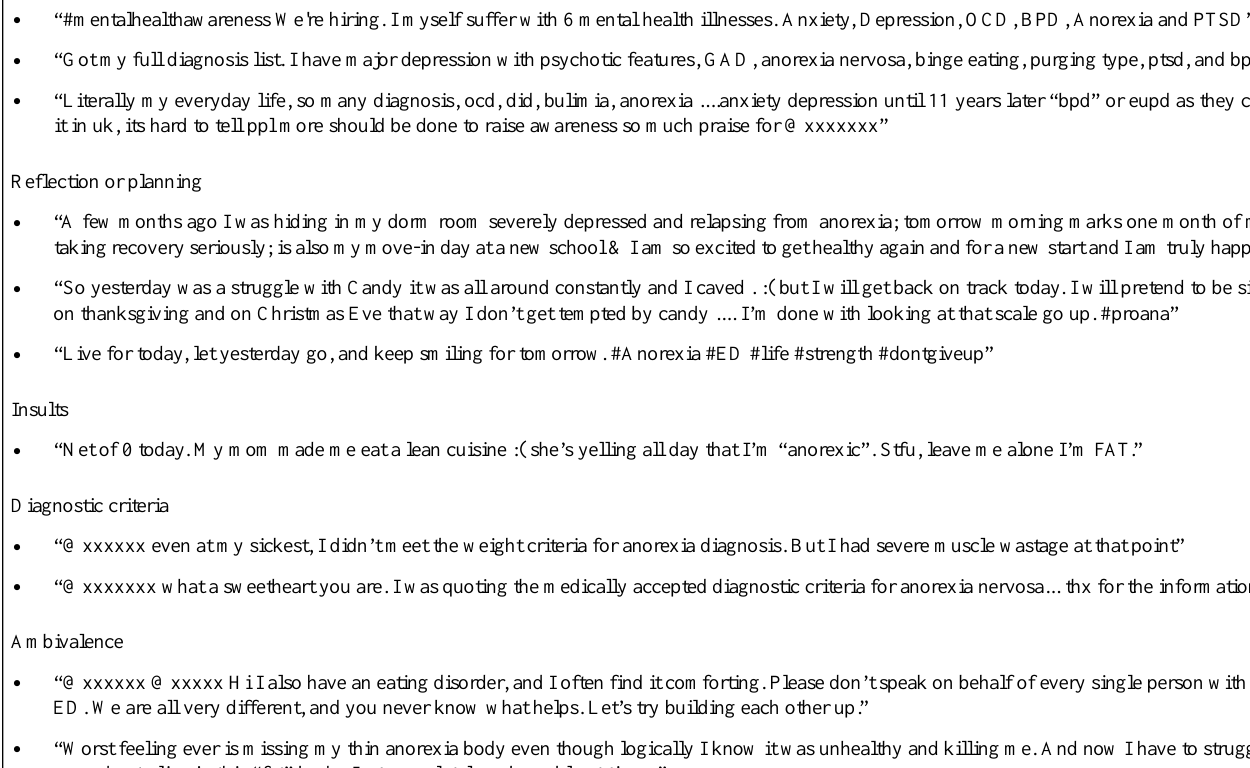
Textbox 3. New topics identified from ED-laypeople tweets in groups 1 and 2.